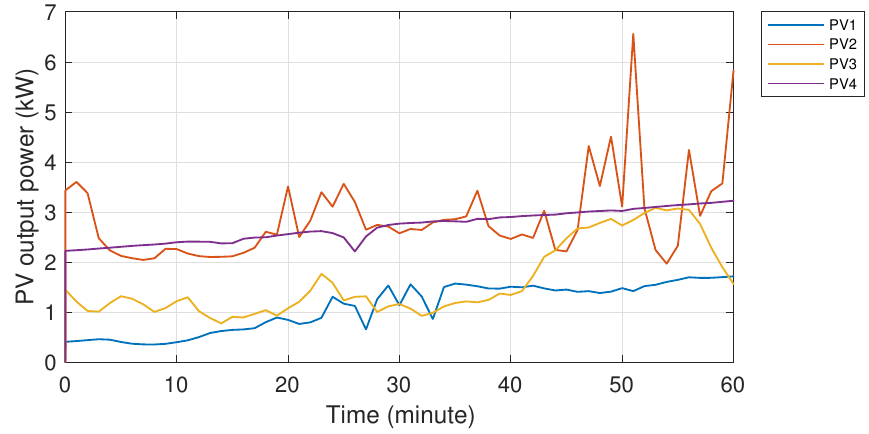
Figure 18. PV sources output